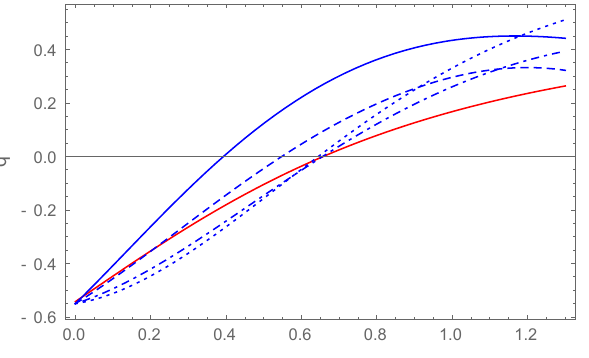
(cid:0) (cid:1) β 2 R µν + β 3 T µν